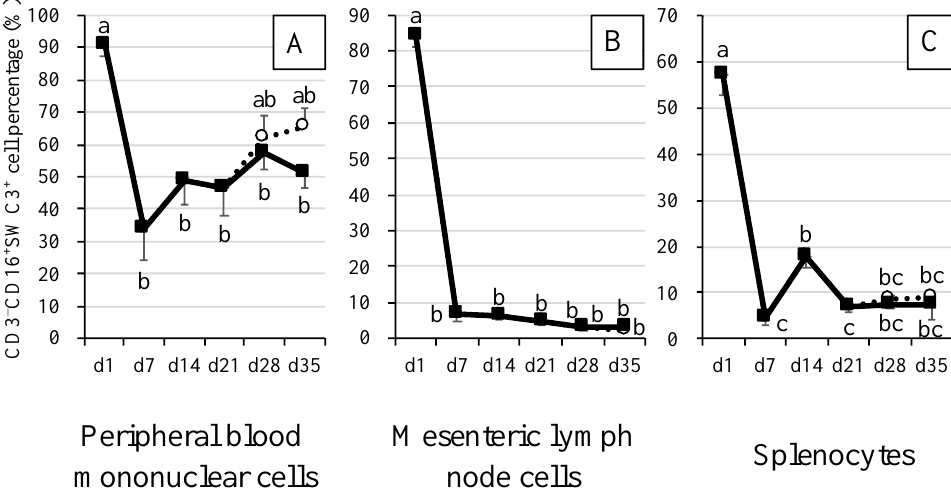
Figure 1. Myeloid cell population in peripheral blood mononuclear cells, mesenteric lymph node (MLN) cells and splenocytes of piglets. CD3 – CD16 + SWC3 + cells were considered as myeloid cells. Closed squares indicate the mean values for suckling piglets. Open circles indicate the mean values for piglets weaned at 21 days of age. The error bars represent the standard errors. Different superscripts indicate significant differences between groups. Panel ( A ), myeloid cell population in peripheral blood mononuclear cells. Panel ( B ), myeloid cell population in MLN cells. Panel ( C ), myeloid cell population in splenocytes.